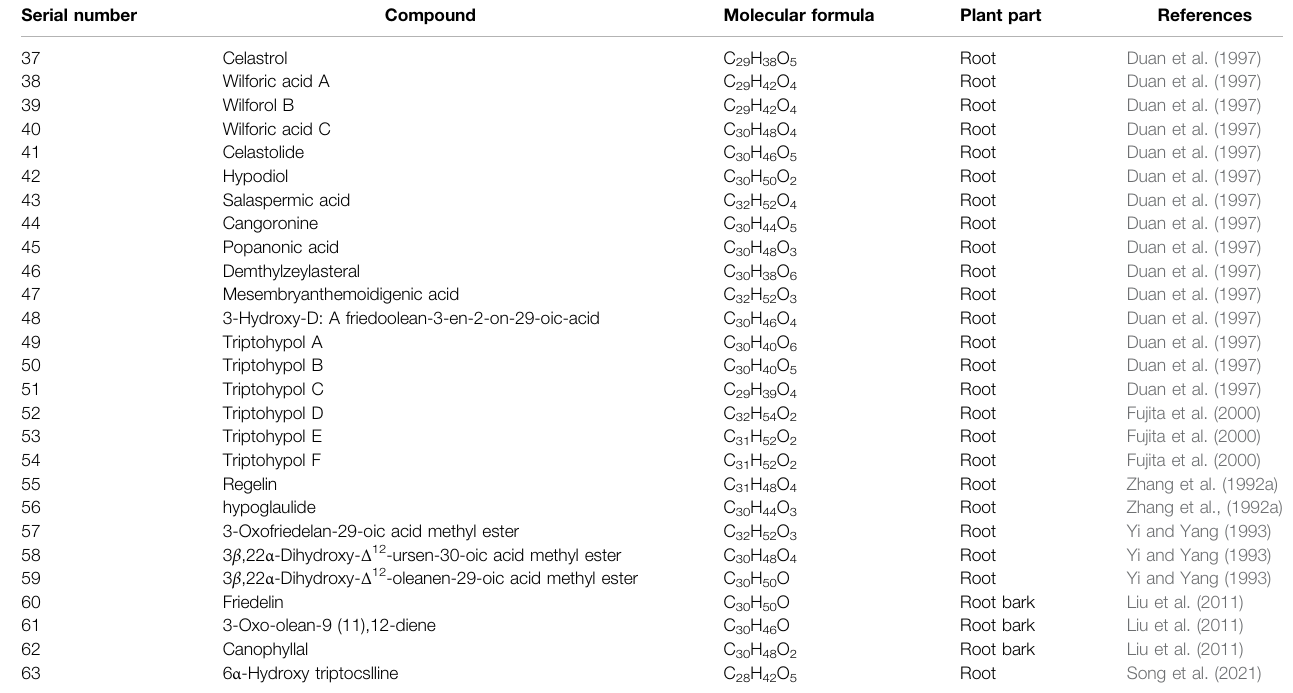
TABLE 2 | Triterpenoids isolated from Tripterygium